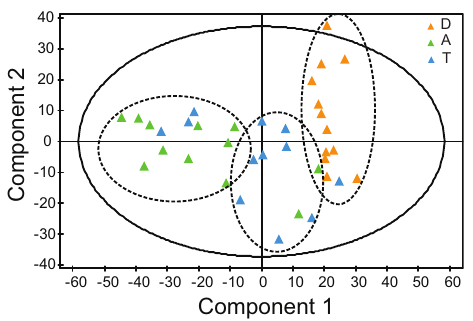
Figure 1. PCA modeling of the gene expression microarray data from diluent- (D), allergen- (A) or allergen + GC treated (T) CD4 + T cells from patients with seasonal allergic rhinitis in the training set.